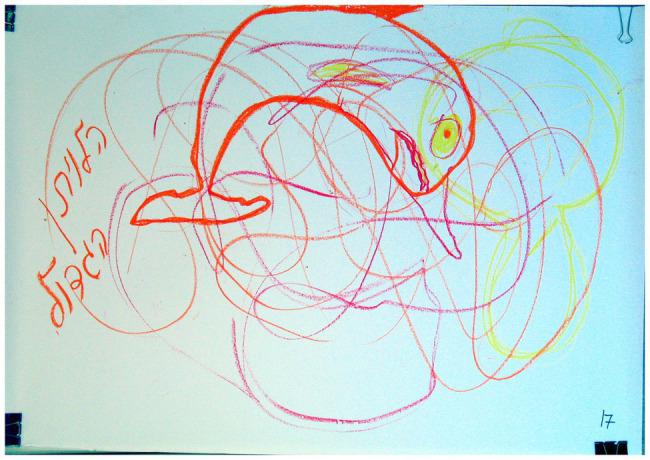
Image of an animal.